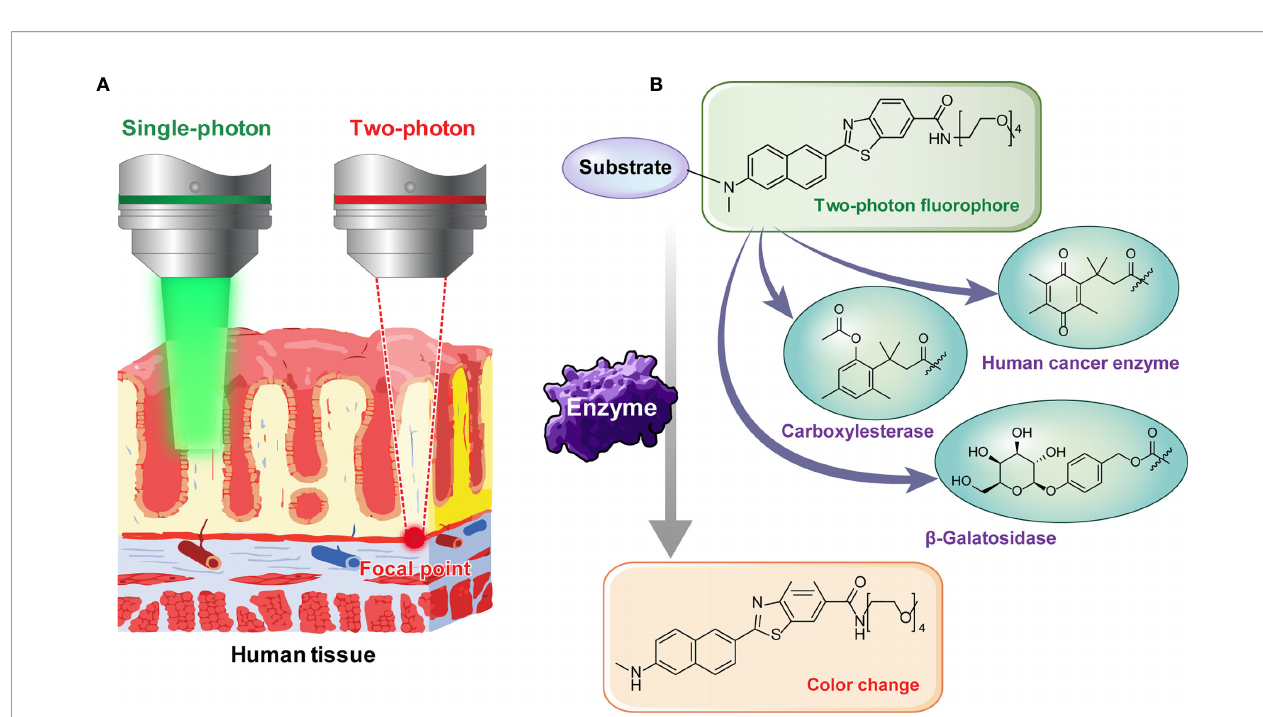
FIGURE 2 | (A) Illustration showing the necessity of two-photon microscopy for deep tissue imaging. (B) Image showing two-photon probes that change color as the substrate is removed by reacting with various